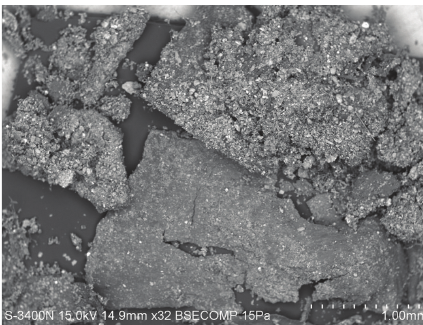
Figure 6: Aggregates from naturally occurring minerals, vegeta- tional detritus, and equivocal biological garbage in a snow sample taken at the Pervomayskiy park area in Blagoveshchensk. Scanning electron microscopy in secondary electrons. Magnification ×